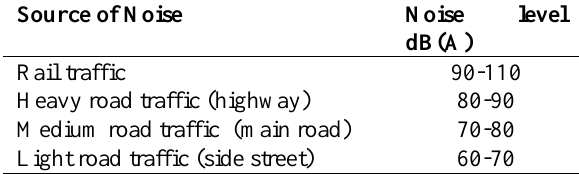
near university of Kirkuk which have heavy traffic volume during all day hours. The values were high during 8:00-8:30 a.m. because the Noise level students starting attendance to their collages , also dB(A) after 12 p.m. when students came back to their 90-110 Rail traffic homes and this make noise level very high in this 80-90 Heavy road traffic (highway) site , maximum value of noise was 94.6 dB(A)as shown in the table(5) which considerably was of 60-70 Light road traffic (side street) higher pollution measurements values comparing to the rest five selected sites.